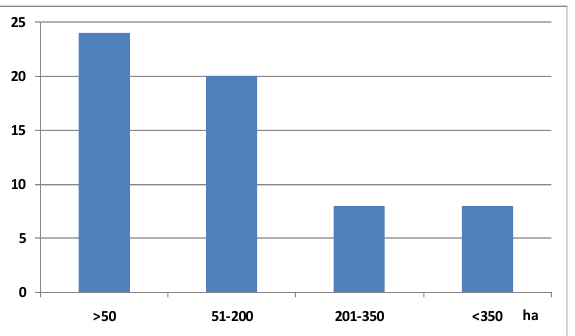
Figure 13. Number of forests stands in the Gala¸ti peri-urban area, distribution by various surface-area categories.